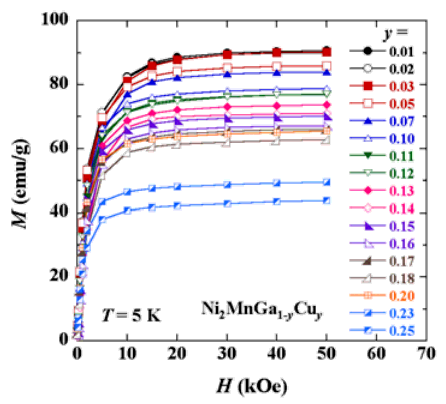
Figure 4. Magnetization curves at 5 K for Ni various concentration y